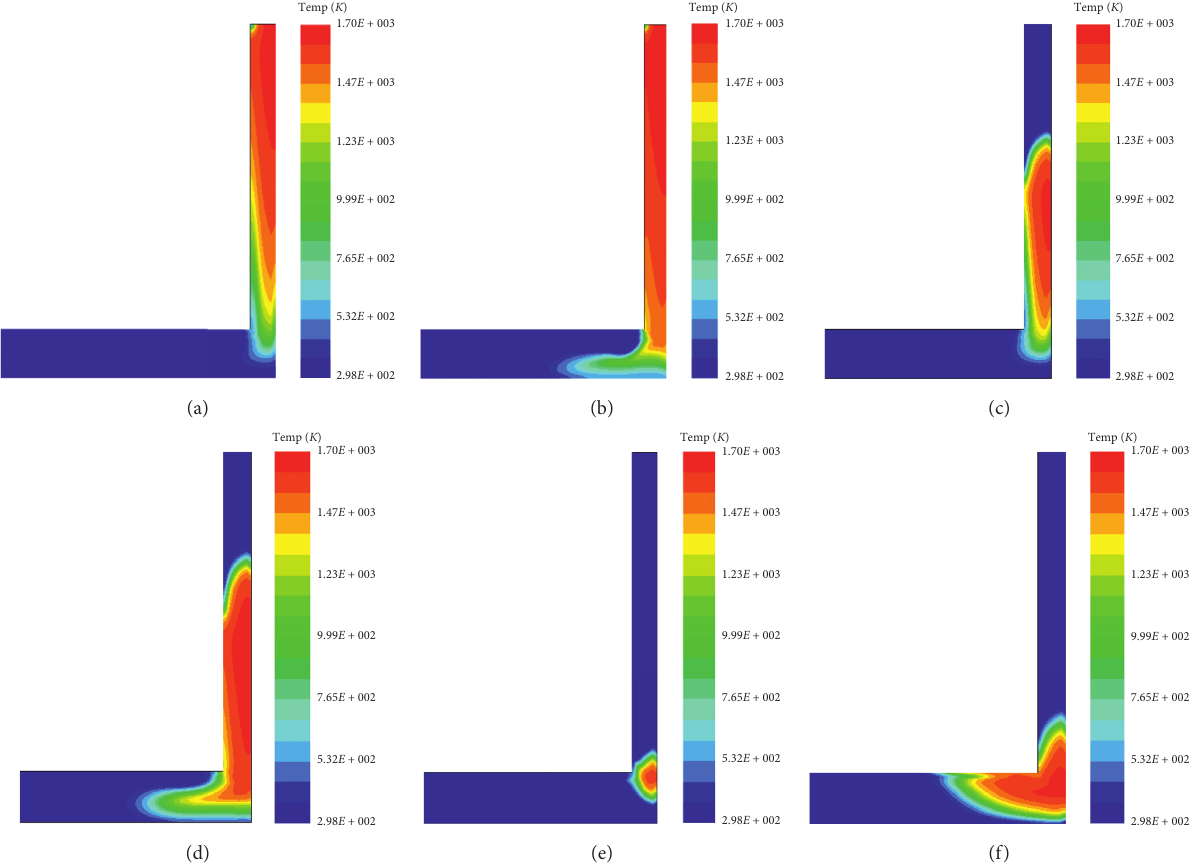
Figure 8: Flame propagation structure under different ignition positions: (a) top ignition 0.21s; (b) top ignition 0.23s; (c) center ignition 0.185s; (d) center ignition 0.205 s; (e) bottom ignition 0.13s; (f) bottom ignition